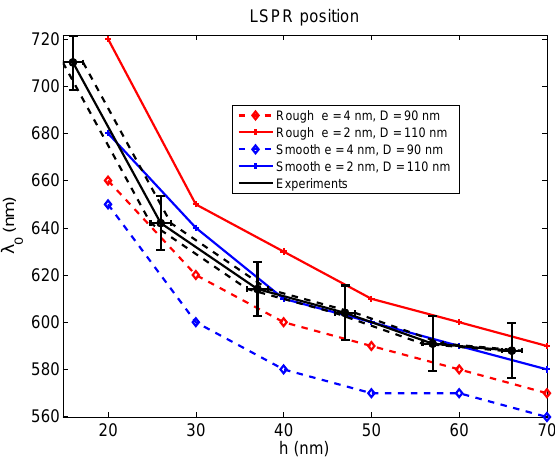
Figure 4: Experimental data from [25] with standard uncer- tainties. Intervals for the position of the LSPR computed with DDA, using experimental uncertainties, for smooth and rough nanostructures.